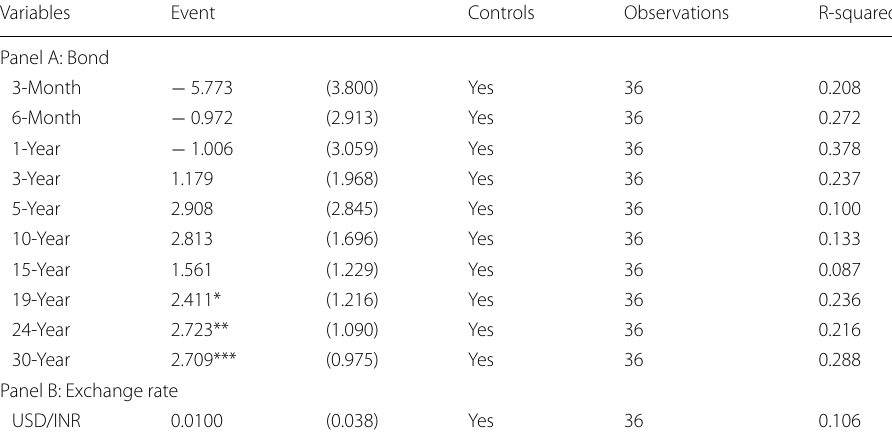
Panel A provides the regression result of the percentage change in the yields on its past value, month dummies, day of the week dummies and Event . Yields of 3-month, 6-month, 1-year, 3-year, 10-year, 15-year, 19-year, 24-year and 30-year government securities are used. Panel B provides a regression result of the percentage change in the exchange rate (USD/ INR) on its past value, month dummies, day of the week dummies and Event . Event is a dummy variable that takes value 1 for the post-event trading day; zero otherwise. Robust standard errors in parentheses *** p < 0.01, ** p < 0.05, * p < 0.1